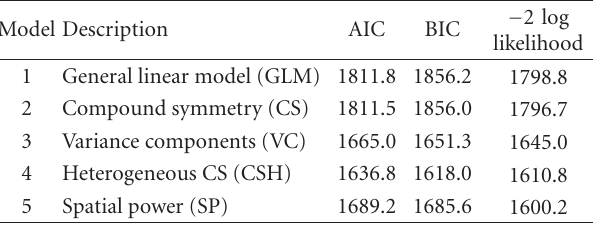
Table 2: Covariance structures using